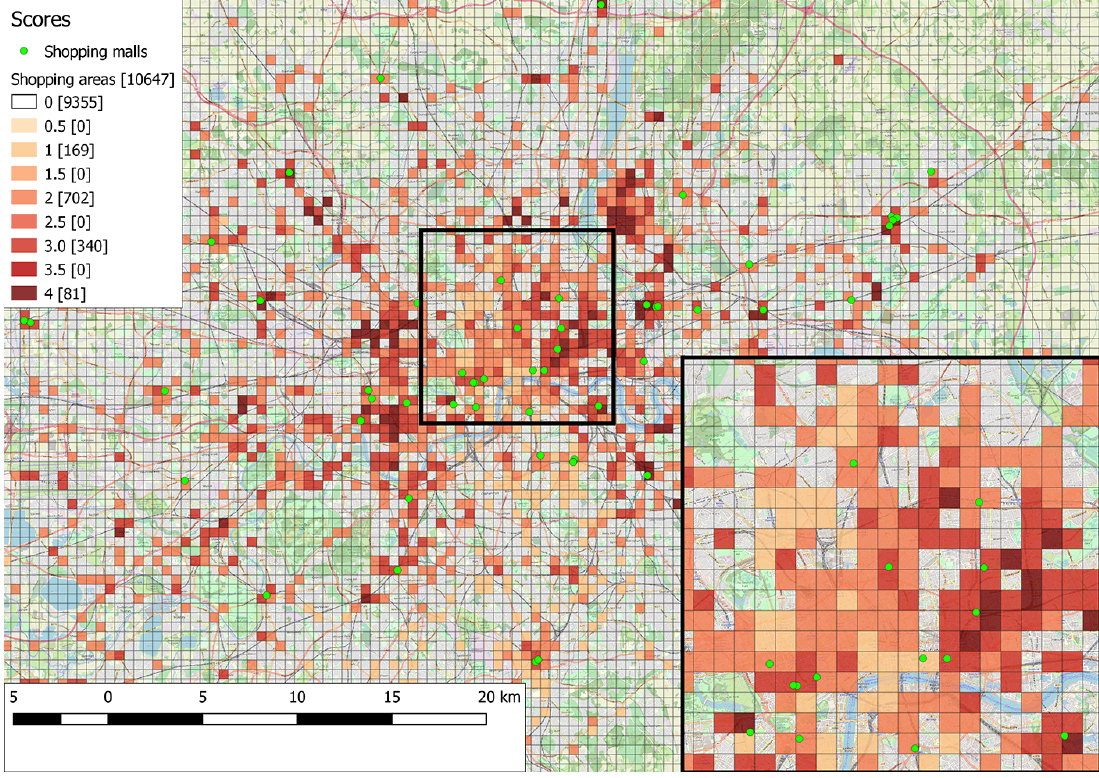
Figure 4. Results using theoretical